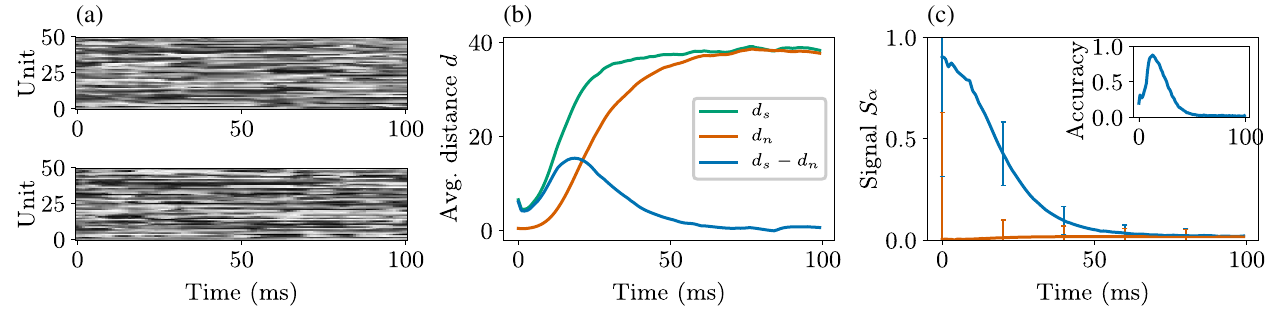
FIG. 12. Transient chaotic SNR amplification in a LSTM network. (a) Chaotic network activity of the first 50 units for two different patterns. Parameters N ¼ 200 and g ¼ 5 . 8 for the hidden to input-, forget- and cell-gates weights and all other weights using a standard U ð − N − 1 2 ; N − 1 2 Þ distribution, with additional detail given in the Appendix 11. Gray scale shows the activity of each hidden unit between − 1 (white) and 1 (black). (b) Evolution of average Euclidean distance between different patterns (green), noisy realizations of a pattern (dark orange), and the difference of the two (blue). The short initial decay in pattern distances is likely due to a short networkwide contraction of the dynamics after pattern presentation caused by the interaction of the gating variable states and the L changed hidden states. (c) Signal of correct readout (blue), incorrect readouts (dark orange), and classification performance